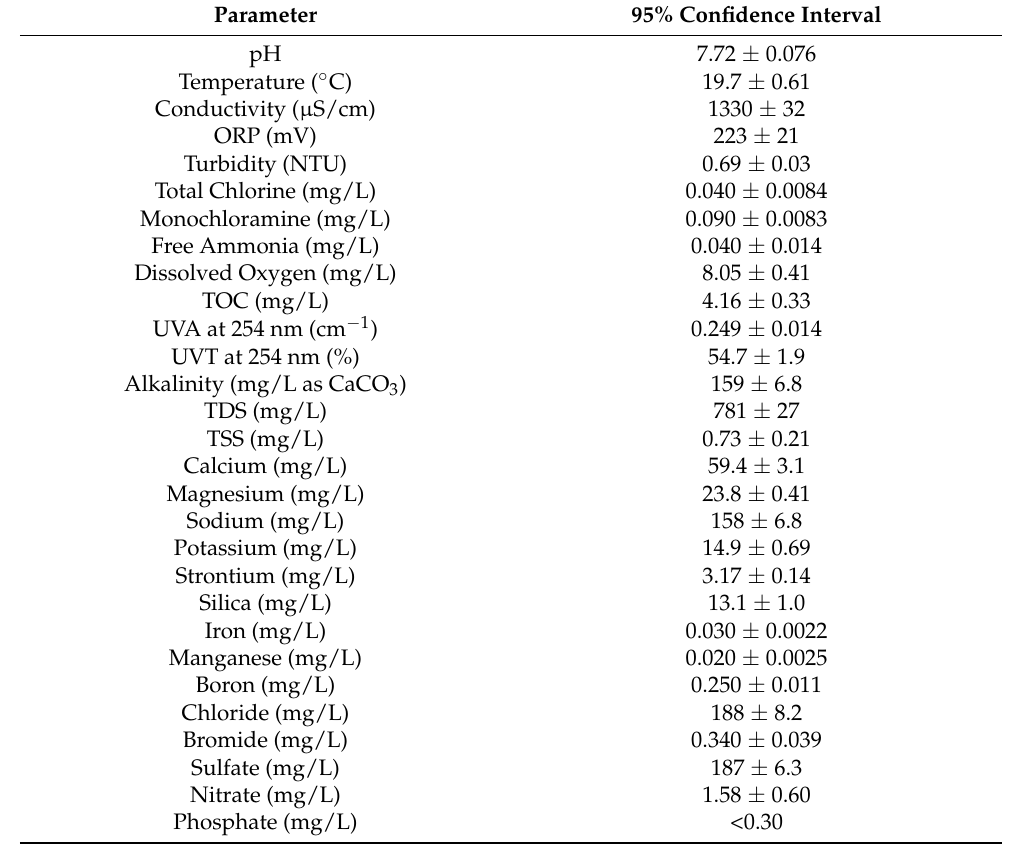
Table 1. Tertiary Effluent Water